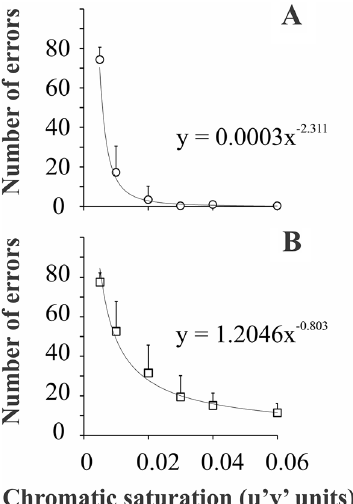
Figure 5. Mean performance of the chromatic discrimination as a function of the chromatic saturation of the target for normal trichromats (A) and participants with CVD (B) . Both groups increased the number of errors as the target was desaturated following a negative power trend (black curve) with higher exponent for normal trichromats than for participants with CVD. Circles and squares represent the mean number of errors from trichromats and participants with CVD, respectively. Error bars represent the standard deviation of the